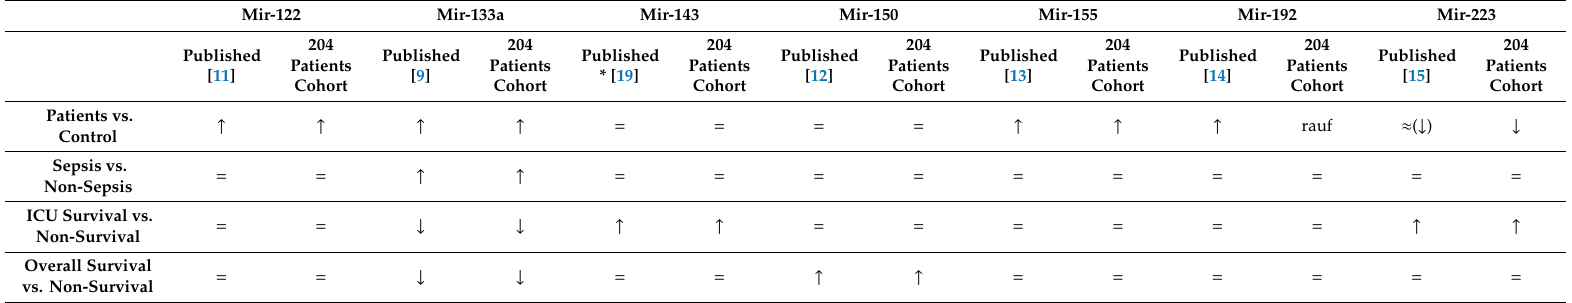
Table 3. Comparison of the data from the current analysis with the respective published